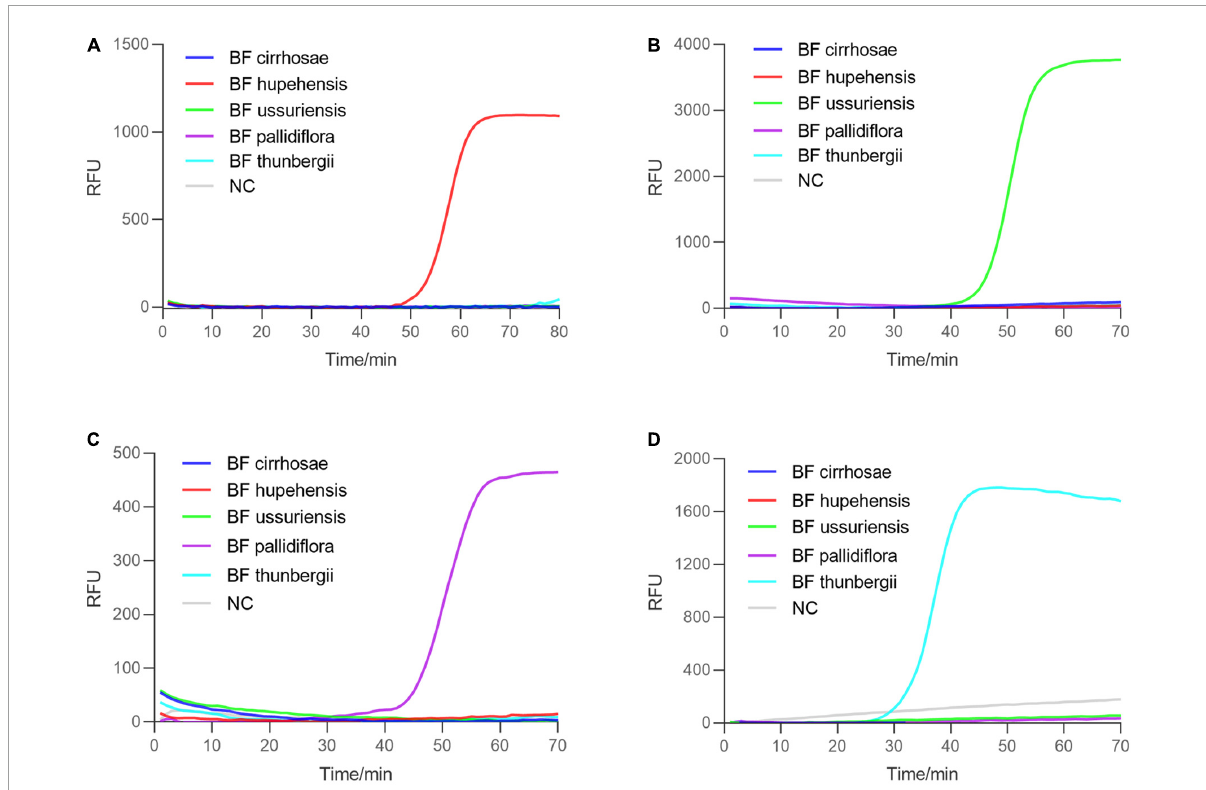
FIGURE5 Real-time Recombinase Assisted Loop-mediated isothermal DNA Amplification detection of four BF. Five BF and blank negative control were detected simultaneously with the corresponding specific primers of BF. (A–D) The amplification plot using the specific RALA primers for BF hupehensis, BF ussuriensis, BF pallidiflora, and BF thunbergii,